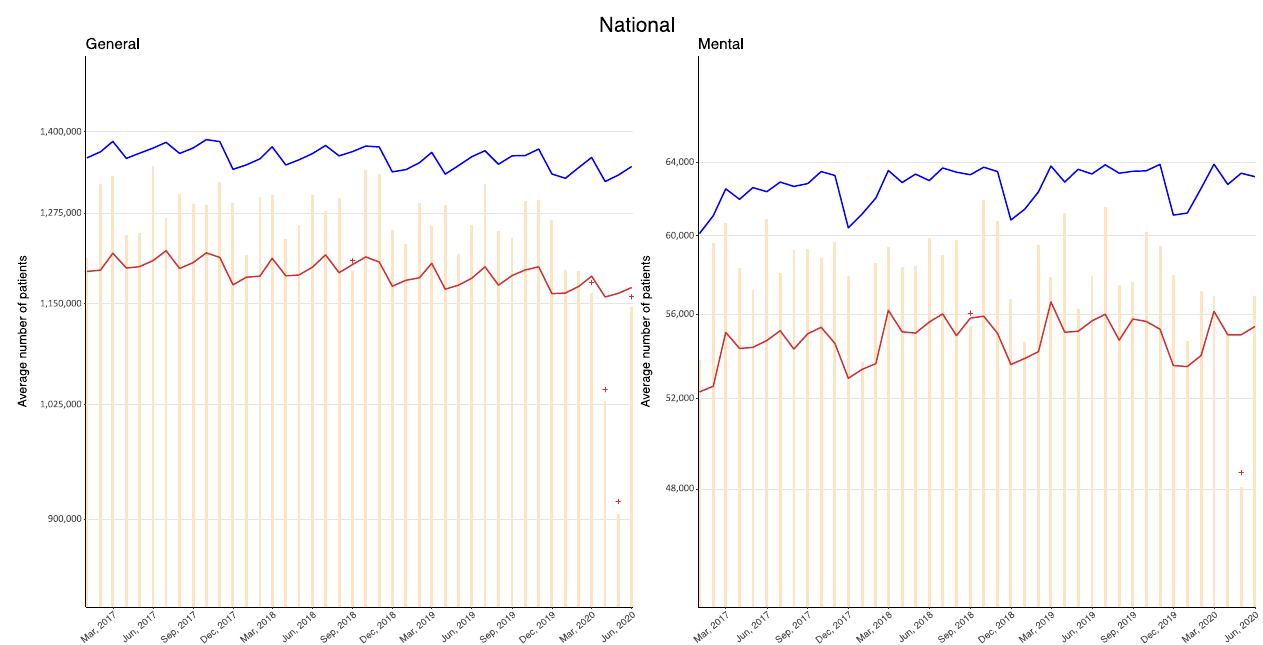
Figure 1. Observed and 95% upper and lower bounds of the expected monthly average number of outpatients per day at general and psychiatric hospitals in Japan up to June 2020. Orange: Observed; blue: Upper bound; red: Lower bound; cross symbols indicate months with the observed value exceeding or falling below the 95% upper or lower bounds. Table 1. Monthly number of observed, excess (percent), and exiguous (percent) values in Japan up to June 2020, by sub- groups.